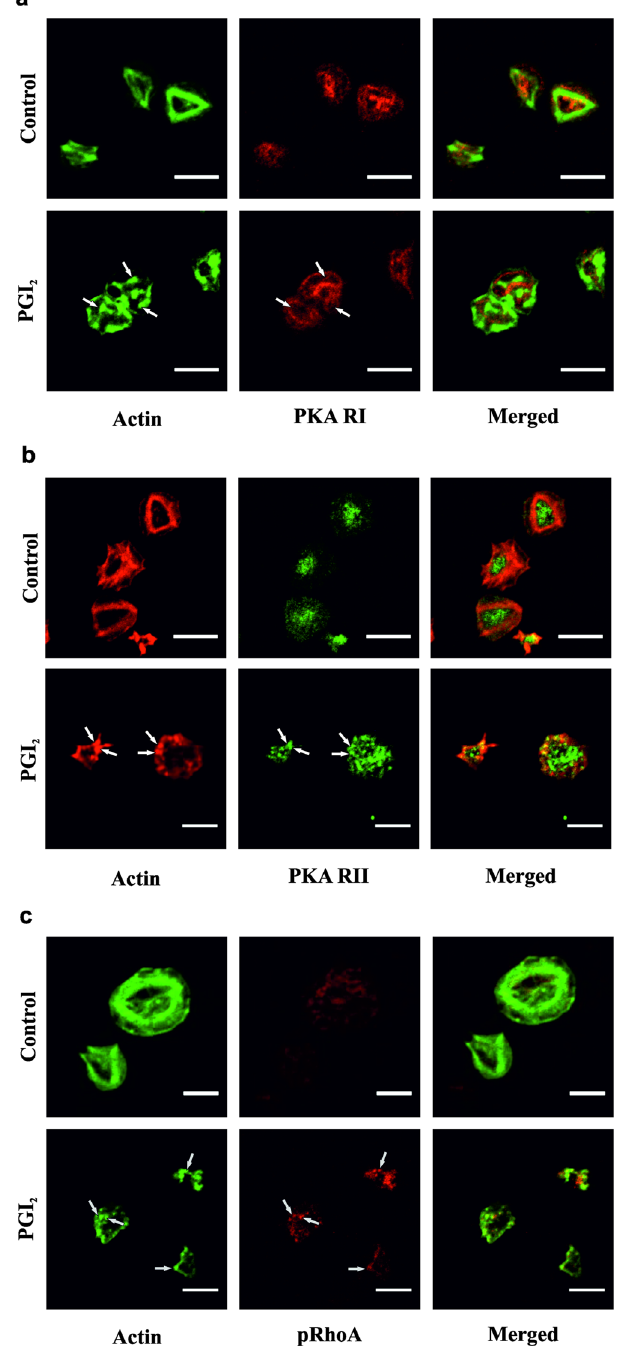
Figure 5. Actin nodules contain PKA signalling proteins. Platelets (2 × 10 7 /ml) were spread on 100 μ g/ml fibrinogen for 25 minutes before being washed with PBS. The platelets were then treated with tyrodes with or without 10 nM PGI 2 for a further 10 minutes. The platelets were then fixed, lysed and stained for either ( a ) PKA RI (1:100), ( b ) PKA RII (1:100) or ( c ) pRhoA (1:1000); and co-stained with actin (FITC-Phalloidin) for 60 minutes, before mounting and imaging the slides. Images are representative of at least 3 experiments. Scale bar is 5 μ